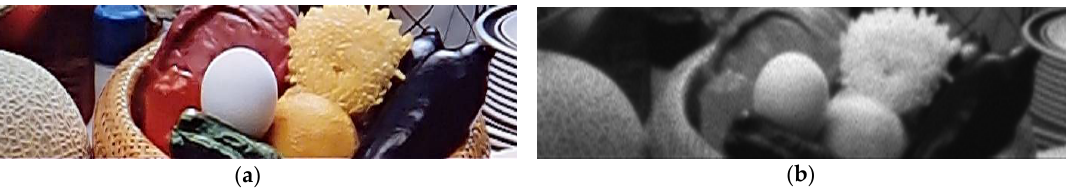
Figure 5. ( a ) RGB and ( b ) NIR images taken by image sensor. The RGB image was reconstructed by using both signals from PD arrays in the top and bottom substrates with IR reduction algorithm. The NIR image was obtained by using only signals from the bottom PD array.